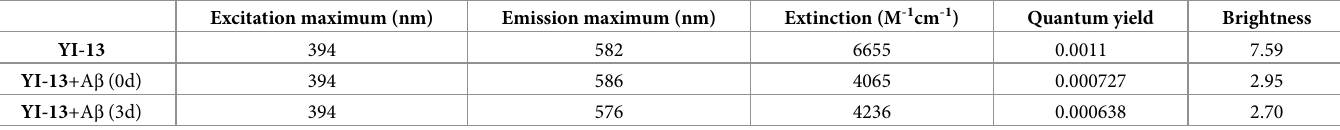
Table 1. Fluorescent properties of selected YI-13 with and without A β